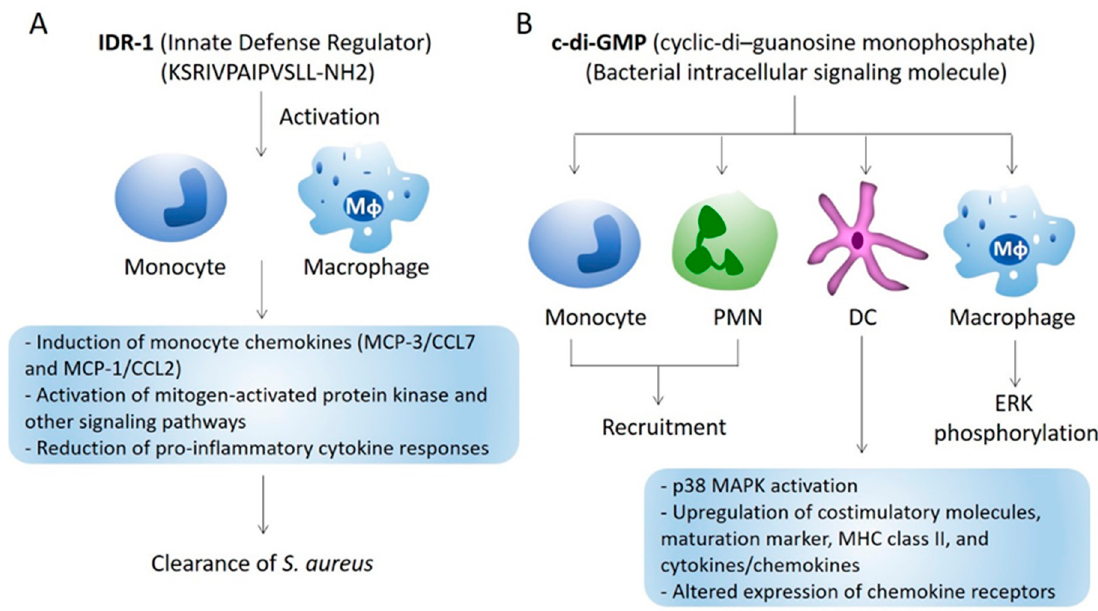
Figure 1. Immune-based strategies targeting chemokines. ( A ) IDR-1, a synthetic host defense peptide derivative, activates immune signaling pathways that increase the levels of infection clearing chemokines, while suppressing pro-inflammatory cytokines such as tumor necrosis factor- α (TNF- α ), leading to S. aureus clearance with little undesirable toxicities. ( B ) A potent bacterial immunostimulatory molecule C-di-GMP induces monocyte/granulocyte recruitment, increased expression of costimulatory molecules, maturation marker, MHC class II, cytokines/chemokines and altered expression of chemokine receptors. The peptide also induces p38 mitogen-activated protein kinase (MAPK) activation in DCs and extracellular signal regulated kinase (ERK) phosphorylation in macrophages.